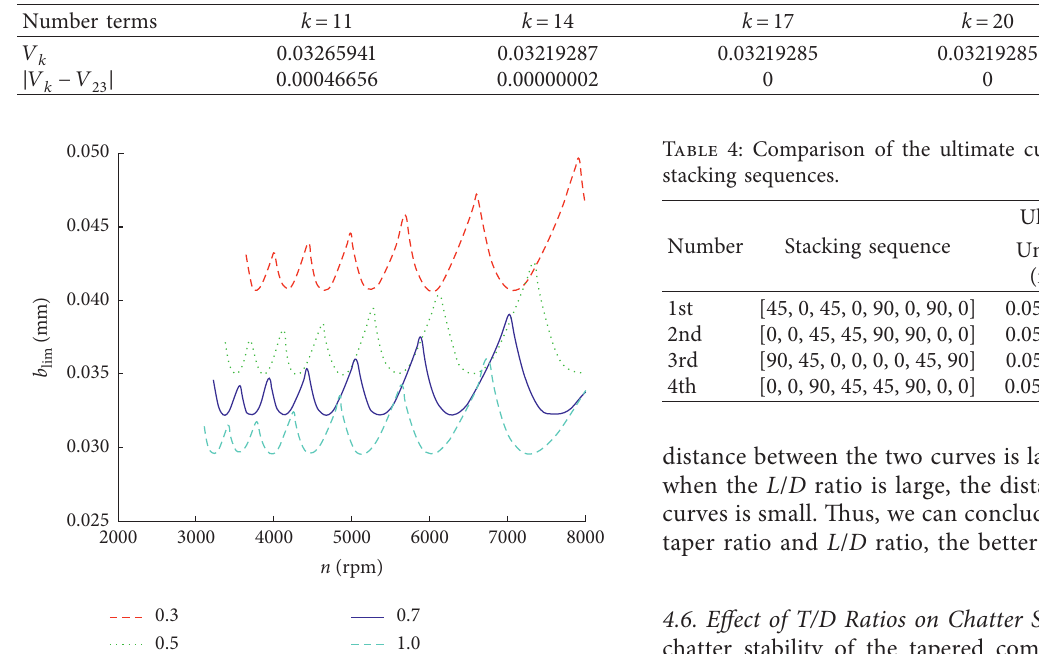
Table 3: Effect of number of terms on prediction accuracy.